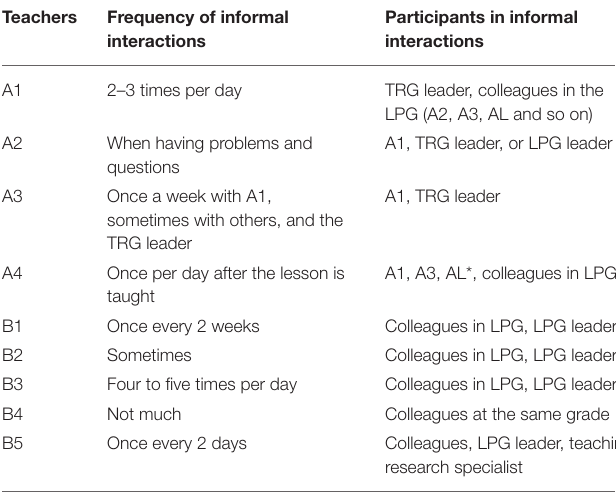
TABLE 3 | Frequency and participation in informal